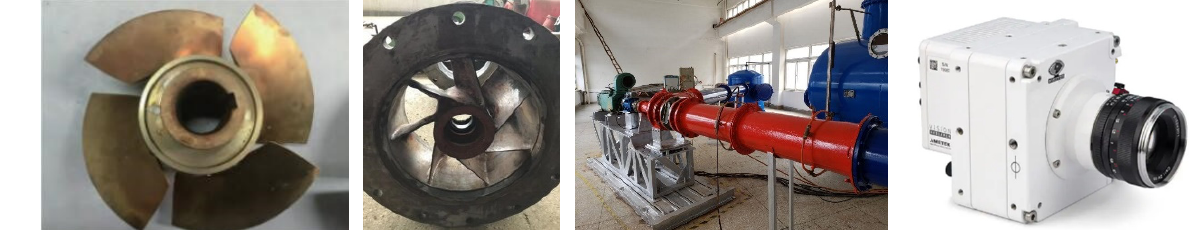
Figure 2. Model test physical objects and high-speed cameras.